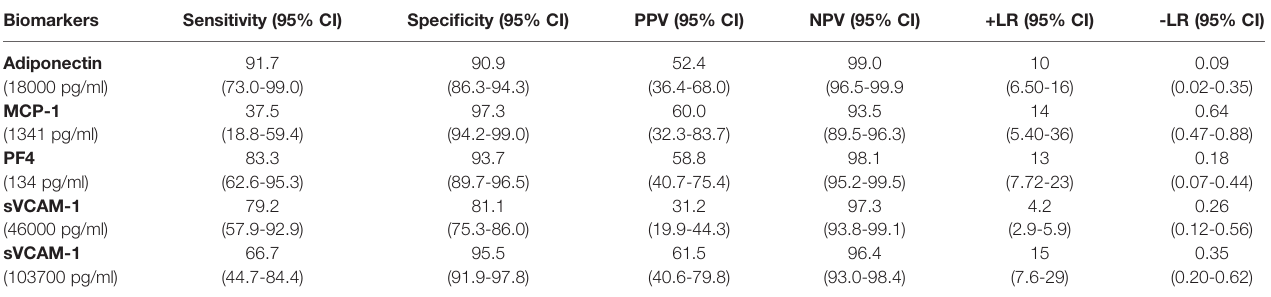
TABLE 3 | Operating characteristics for individual